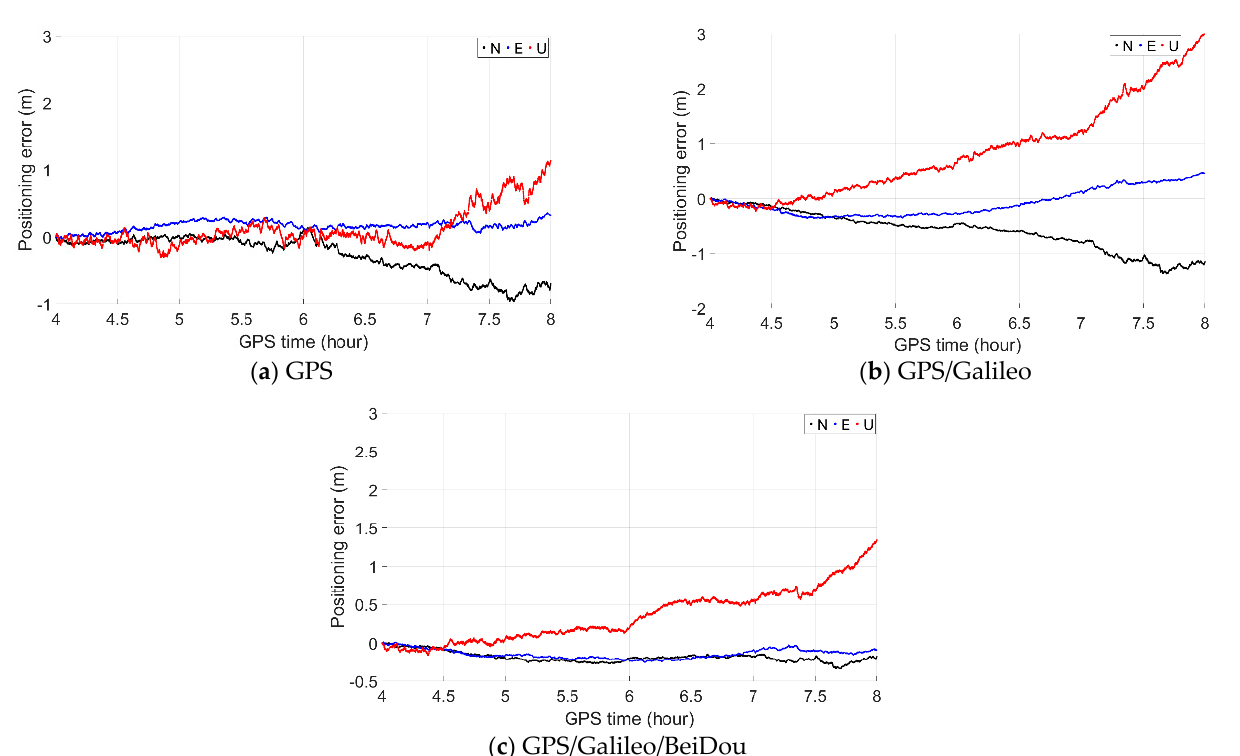
Figure 11. Time-relative positioning errors with ( a ) GPS, ( b )GPS/Galileo and ( c ) GPS/Galileo/BeiDou.